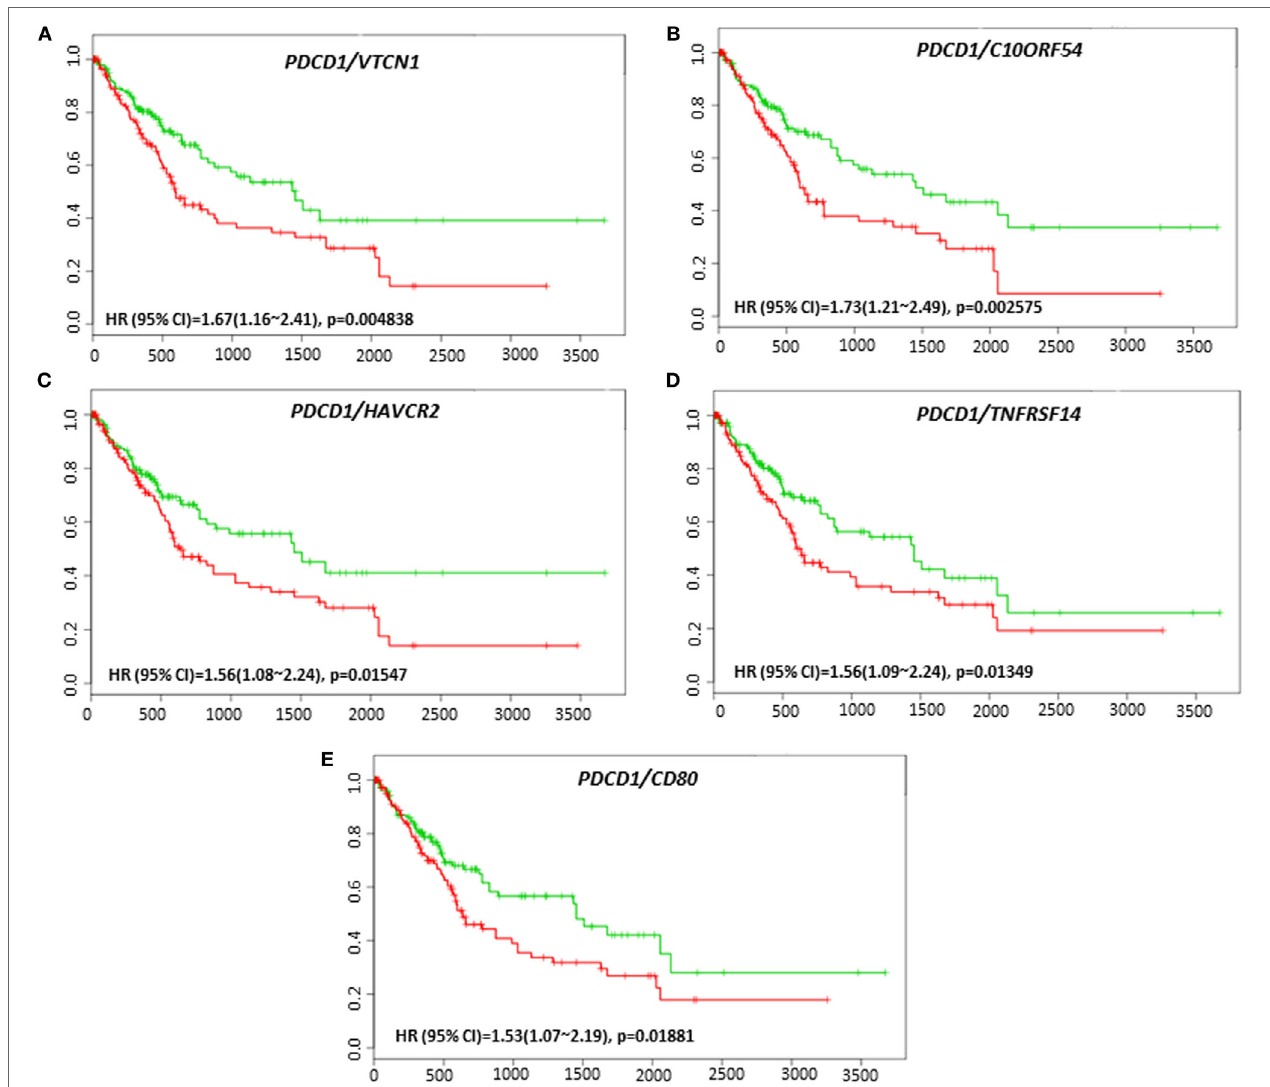
FigUre 8 | Relationship of immune modulators in combination with PDCD1 and recurrence-free survival in HCC patients. Kaplan–Meier curves produced using the SurvExpress for the analysis of recurrence-free survival and gene expression of (a) PDCD1/VTCN1 , (B) PDCD1/C10ORF54 , (c) PDCD1/HAVCR2 , (D) PDCD1/ TNFRSF14 , and (e) PDCD1/CD80 in HCC patient samples. Green curve represents low-risk group, while red curve represents high-risk group. The study time (months) is presented on the x -axis. The insert shows the hazard ratio, confidence interval, and Log-Rank Equal Curves p value. Markers ( + ) represent censoring